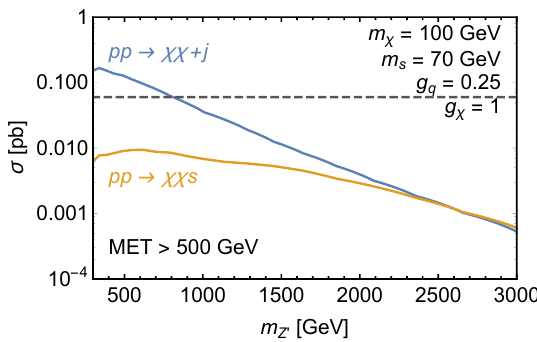
Figure 2 . Total cross section for pp ! (cid:31)(cid:31) + j and pp ! (cid:31)(cid:31)s as a function of the Z 0 mass for a speci(cid:12)c choice of the remaining masses and couplings. To calculate the cross section, we require =E > 500 GeV after showering and impose the selection cuts from the most recent ATLAS mono-jet T search [63] (see text for details). The dashed line indicates the corresponding bound on the cross section obtained by